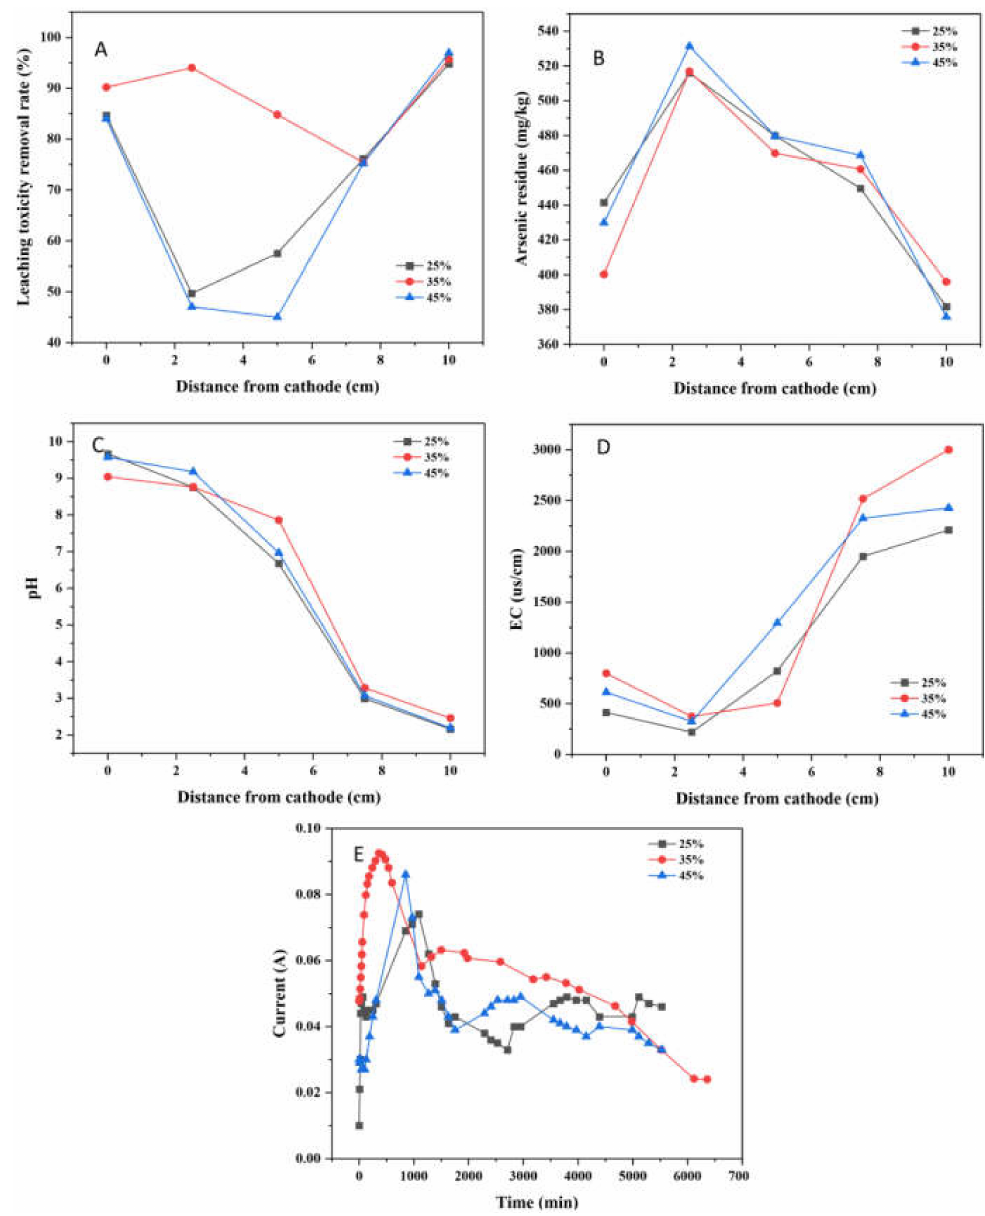
Figure 8. Effect of moisture content for the remediation of arsenic-contaminated soil by EK-PRB (Leaching toxicity removal rate ( A ), arsenic residue ( B ), pH ( C ), EC ( D ) and current ( E